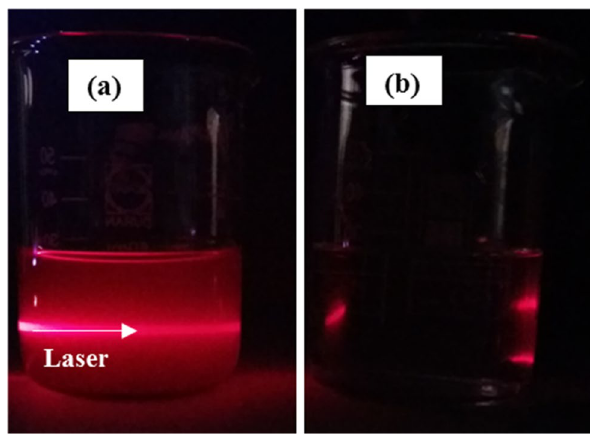
Figure 2. Tyndall effect for the CQD nanofluid ( a ) and the base fluid ( b ).